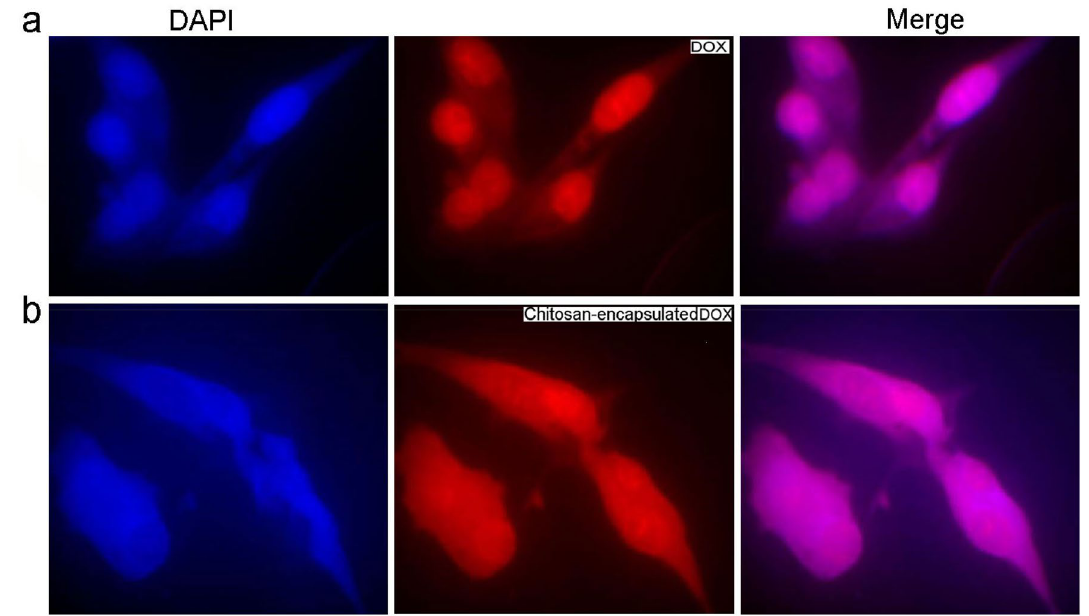
Figure 10. ( a ) Cellular uptake behavior of DOX by MCF-7 breast cancer cell line. ( b ) Cellular uptake behavior of CS-DOX by MCF-7 breast cancer cell line. DAPI is used to stain nuclei of cells. Due to its fluorescent nature, DOX causes the cell cytoplasm to turn red on the fluorescent imaging. The images confirm the uptake of the drug by the